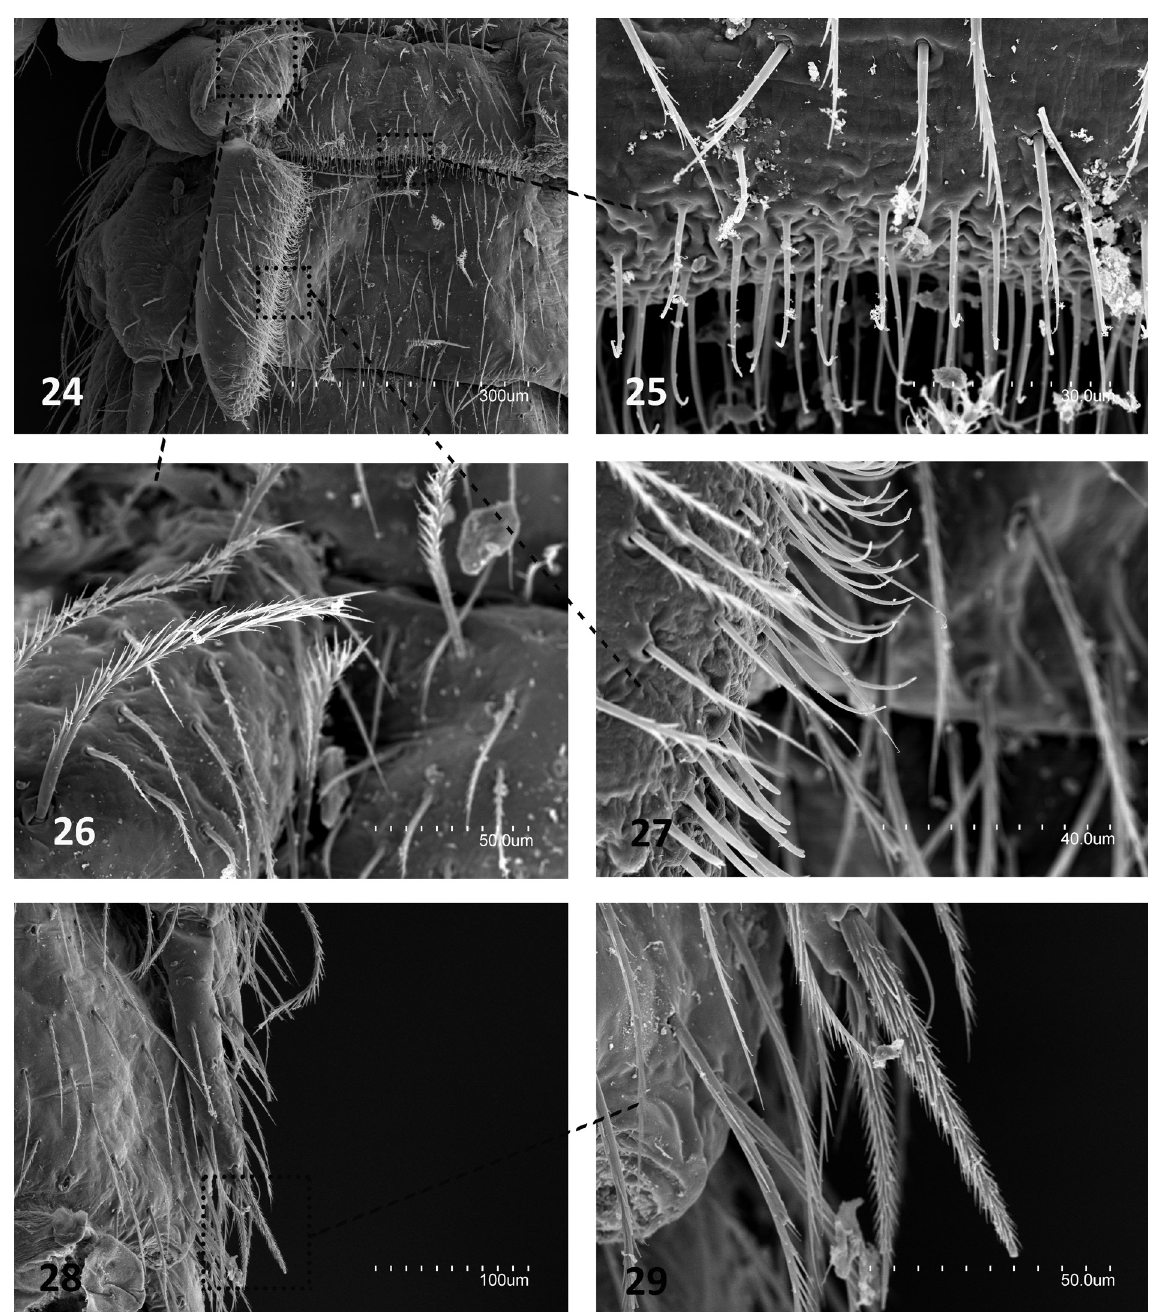
Figs 24–29. Plusiocampa ( Plusiocampa ) boneti boneti Condé, 1948, ♂, from Cova Mora, Huesca, Spain (Coll. AS). 24 . Urosternite I, right side. 25 . Urosternite I, detail of glandular g urosternite I. 27 . Appendage of urosternite I, glandular a 29 . Distal stylus of left urosternite VI,